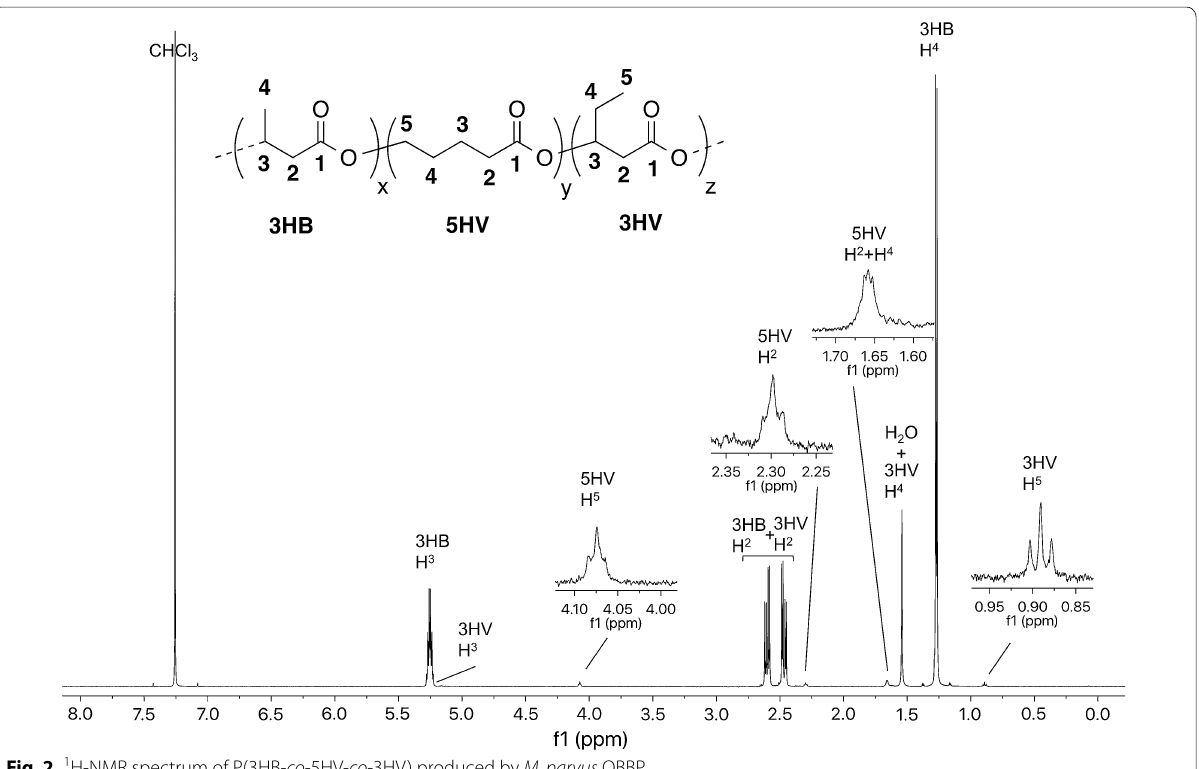
Fig. 2 1 H-NMR spectrum of P(3HB- co -5HV- co -3HV) produced by M. parvus